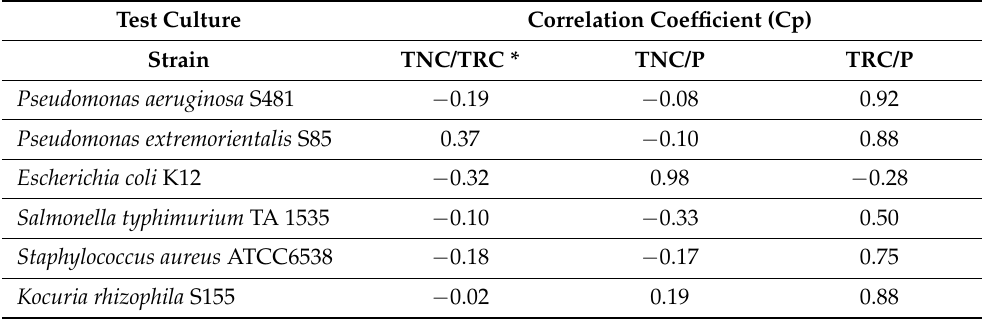
Table 2. Values of correlation coefficients between indicators of total number of cells (TNC), number of thermoresistant cells (TRCs), and persister (P) cells. Test Culture Correlation Coefficient (Cp) Strain TNC/TRC * TNC/P TRC/P Pseudomonas aeruginosa S481 − 0.19 Pseudomonas extremorientalis